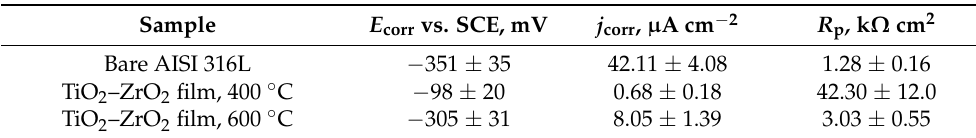
Table 4. Values of open-circuit potential ( E oc ) measured in 0.5 mol dm − 3 HCl solution (mean value ± standard